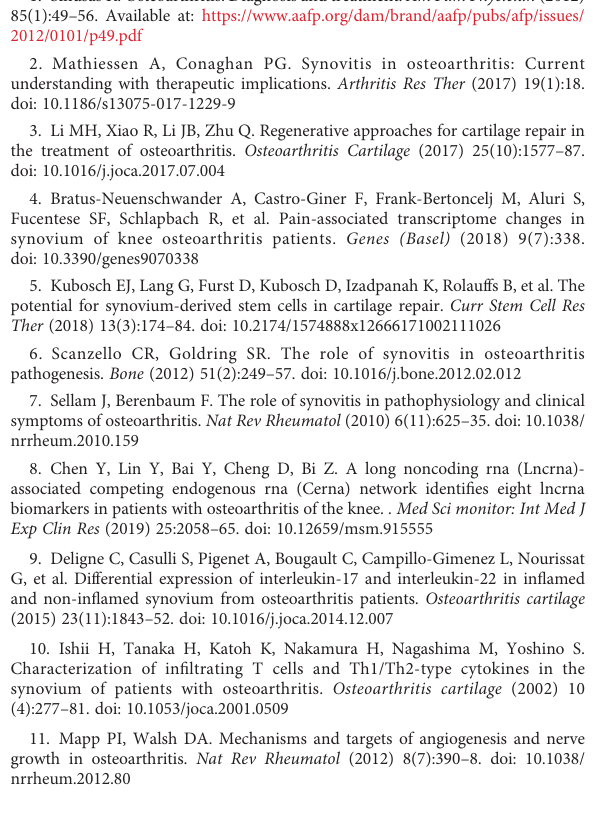
SUPPLEMENTARY FIGURE 1 GO functional analysis 172 genes associated with OA. (A – C) The GO analysis result showed by biology process, cellular component, and molecular function. SUPPLEMENTARY FIGURE 2 Single-cell analysis with three synovial samples of OA. (A) The UMAP showing 10 cell types were identi fi ed. (B) The percentage of 10 cell types in each sample. (C) Heatmap of single-cell data based on the UMAP plot. Columns represent individual cells and rows represent genes. (D) The dot plot showing the expression of marker genes in each cell type; the size of the dot re fl ects the percentage of cells expressing the gene; expression levels are color coded. (E) UMAP plot showing the marker gene expression in all